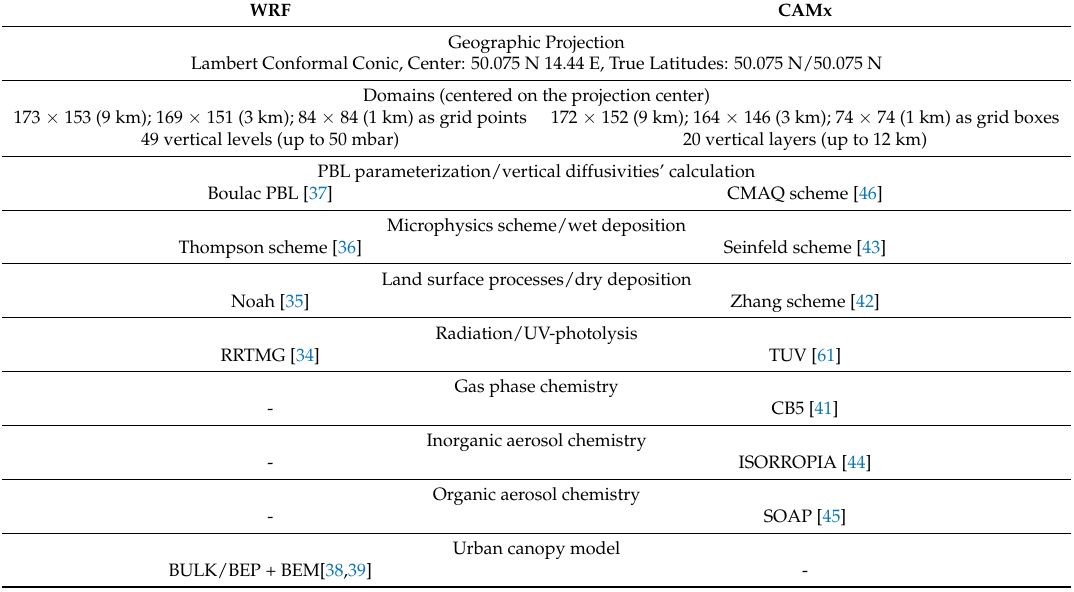
Table 1. Model configuration for WRF (left) and CAMx (right). CMAQ, Community Multiscale Air Quality Modeling System; RRTMG, Rapid Radiative Transfer Model for General Circulation Models; TUV, Tropospheric Ultraviolet-Visible Model; CB5, Carbon Bond chemical mechanism; SOAP, Secondary Organic Aerosol Processor; BEP + BEM, Building Environment Parameterization linked to Building Energy